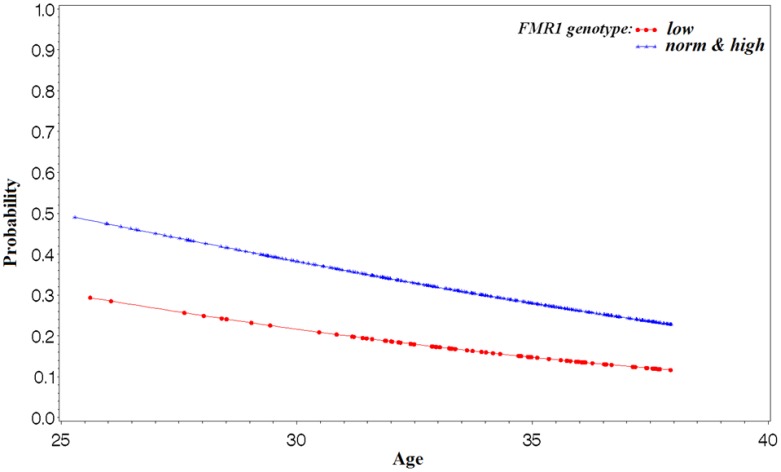
Predicted probabilities of clinical IVF pregnancy in infertile patients based on age and FMR1.